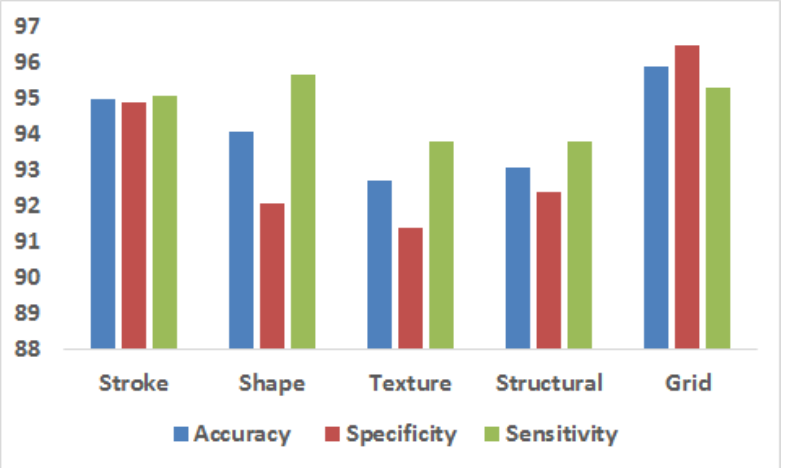
Figure 4. Comparison results of accuracy, specificity and sensitivity for various features.